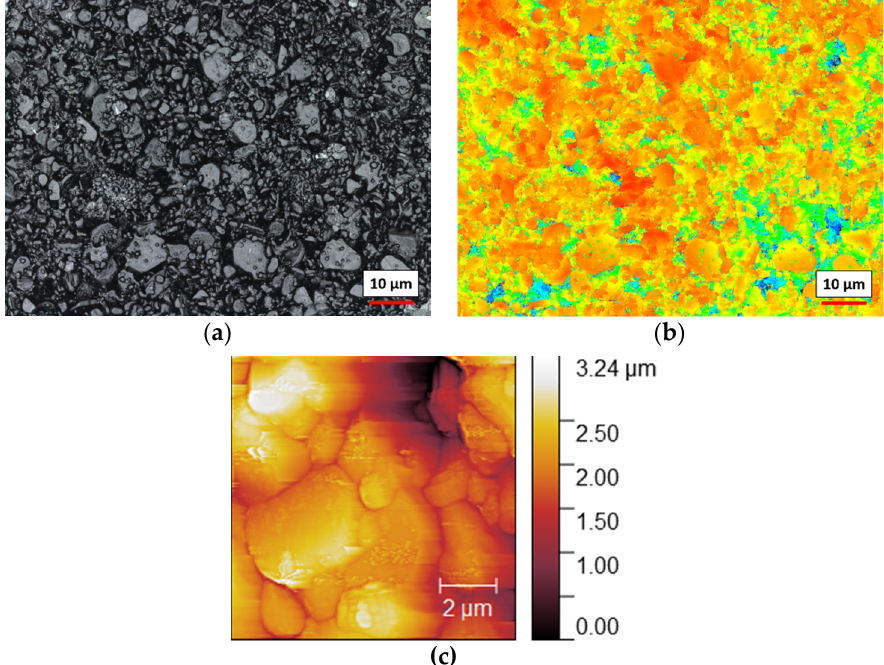
Figure 1. Morphological characterization of the Al 2 O 3 porous ceramic filter: ( a ) confocal laser scanning microscopy (CLSM) images with 150 × magnification show the pressed Al 2 O 3 grains of different sizes; ( b ) the height profile of the same section; ( c ) atomic force microscopy (AFM) scan images of a 10 µm × 10 µm area. The zero reference was set on lowest point of the picture. A pore is visible in the upper right corner.